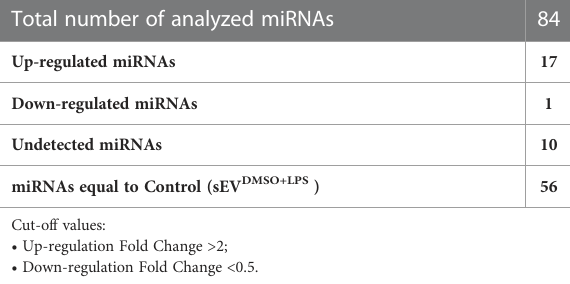
TABLE 1 Summary of sEV PBDE+LPS array data comparedto control(sEV DMSO+LPS ). Total number of analyzed miRNAs Up-regulated